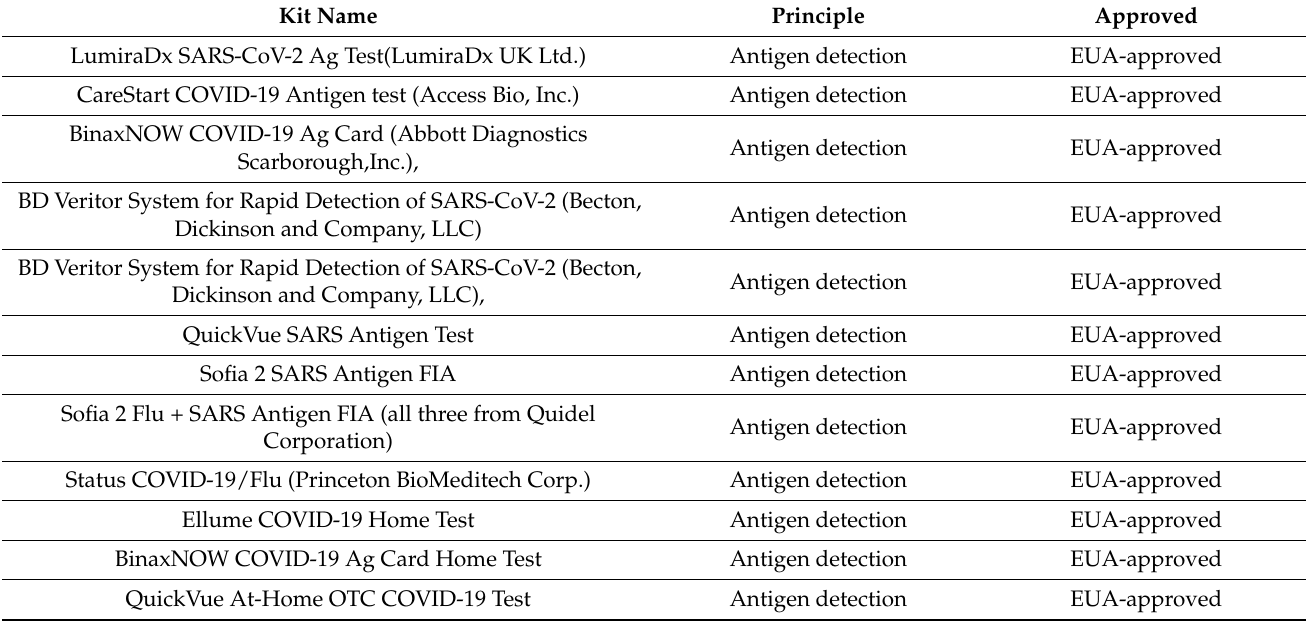
Table 5. List of EUA-approved POC devices working on antigen detection principle for SARS-CoV-19